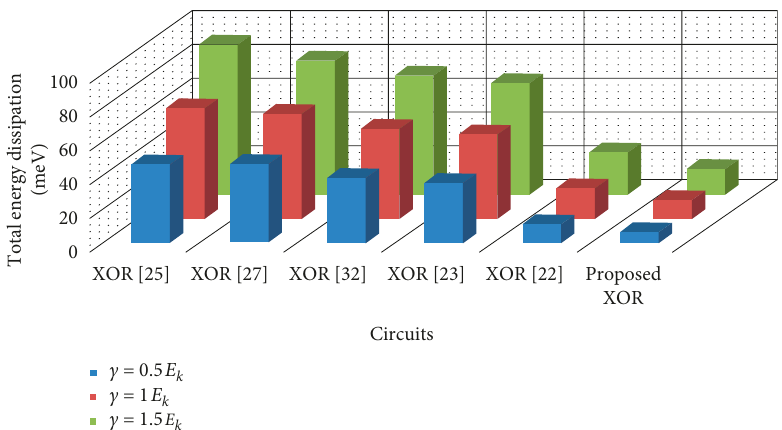
Figure 9: The total power dissipation of the presented XOR gate at three different tunneling energy levels ( T